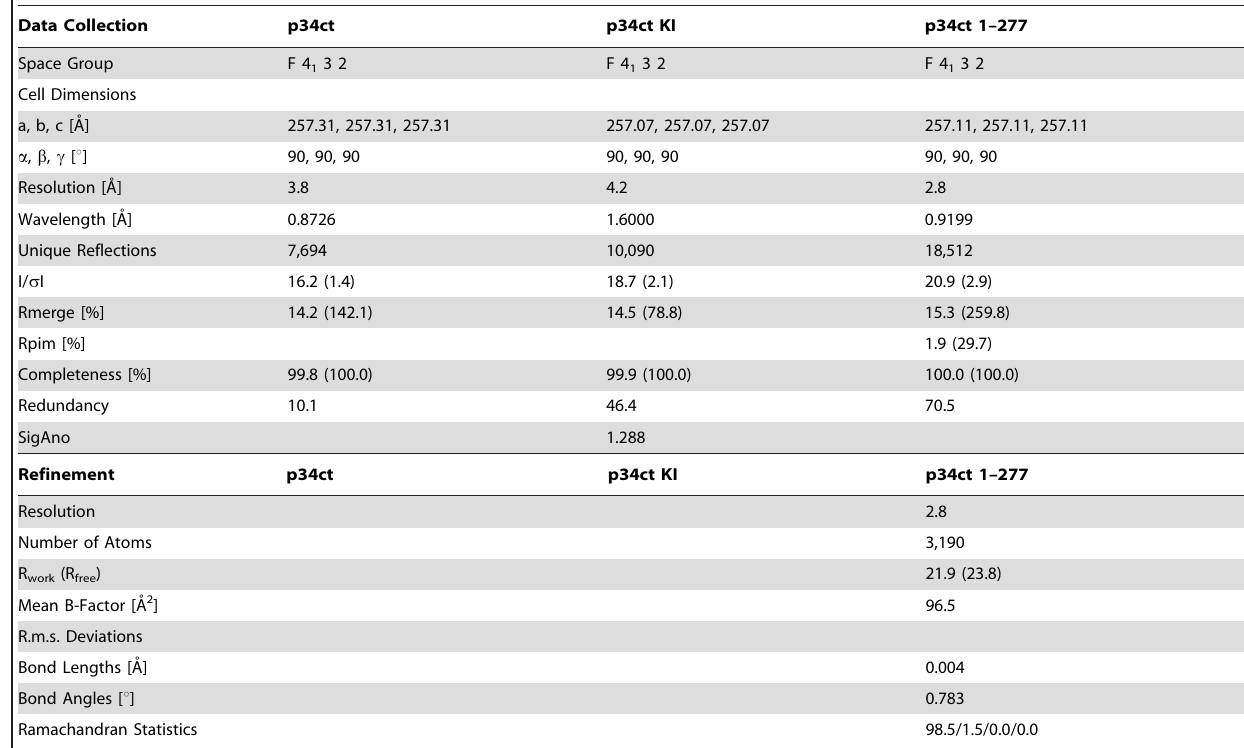
Table 1. Data Collection and Refinement